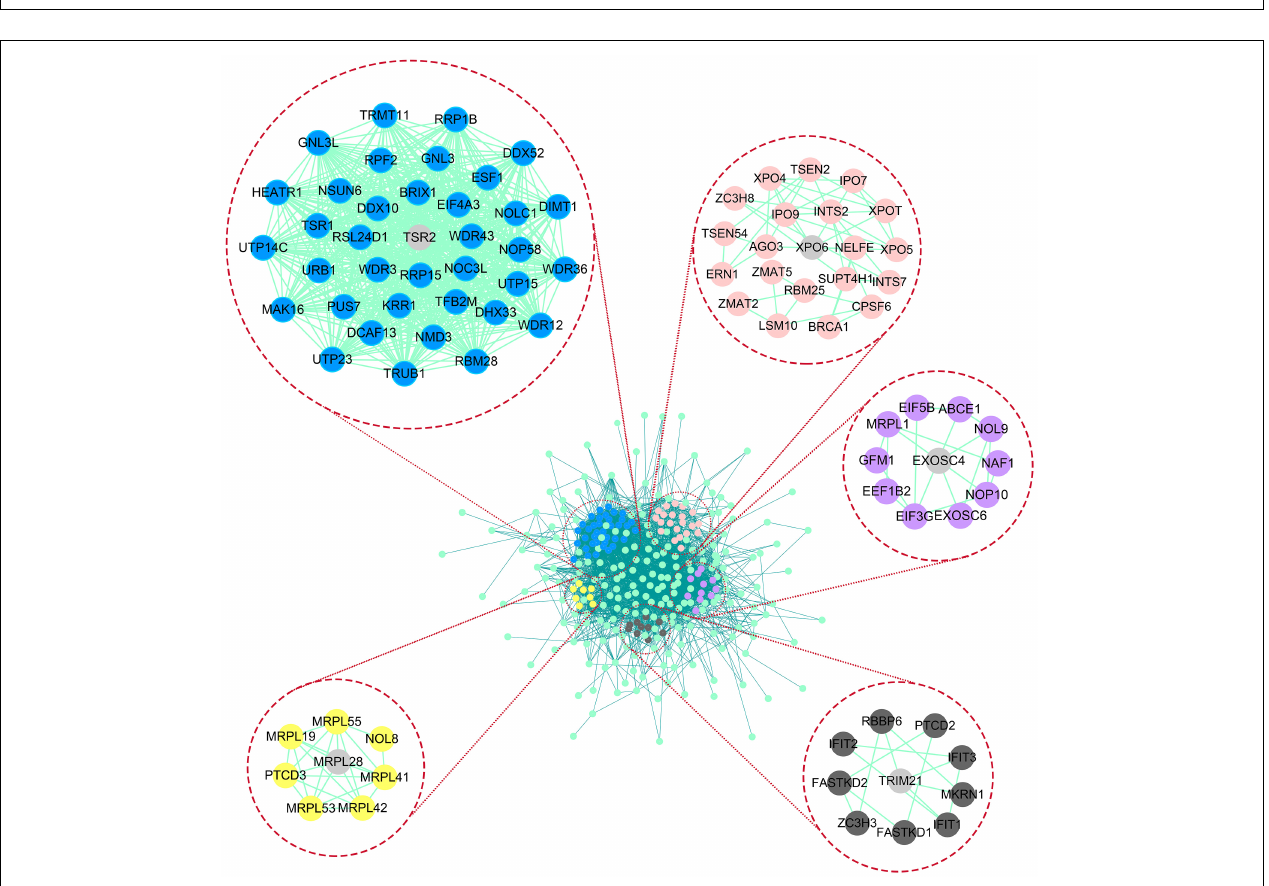
selection is the main means to prevent recurrence, but it depends on reliable prognostic markers to determine the prognosis of patients. Therefore, our systematic estimation of RBP-encoding